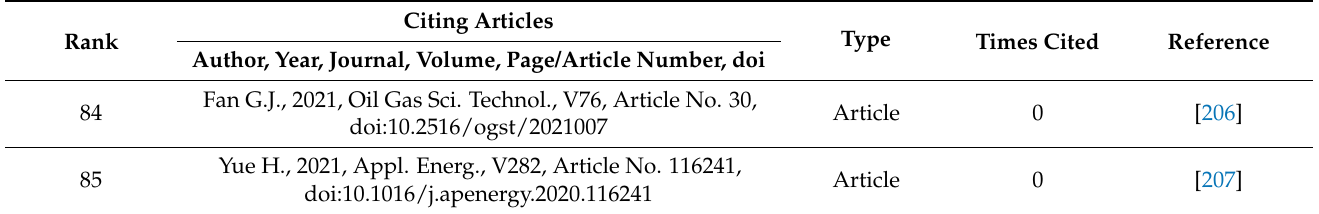
Table A1. Citing articles of ‘Zhou N., 2018, NAT. ENERGY, V3, P978,